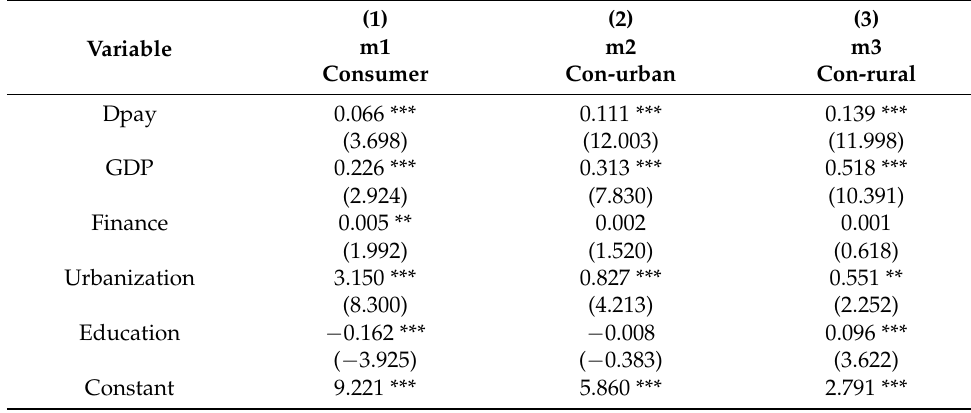
Table 15. Urban and rural heterogeneity